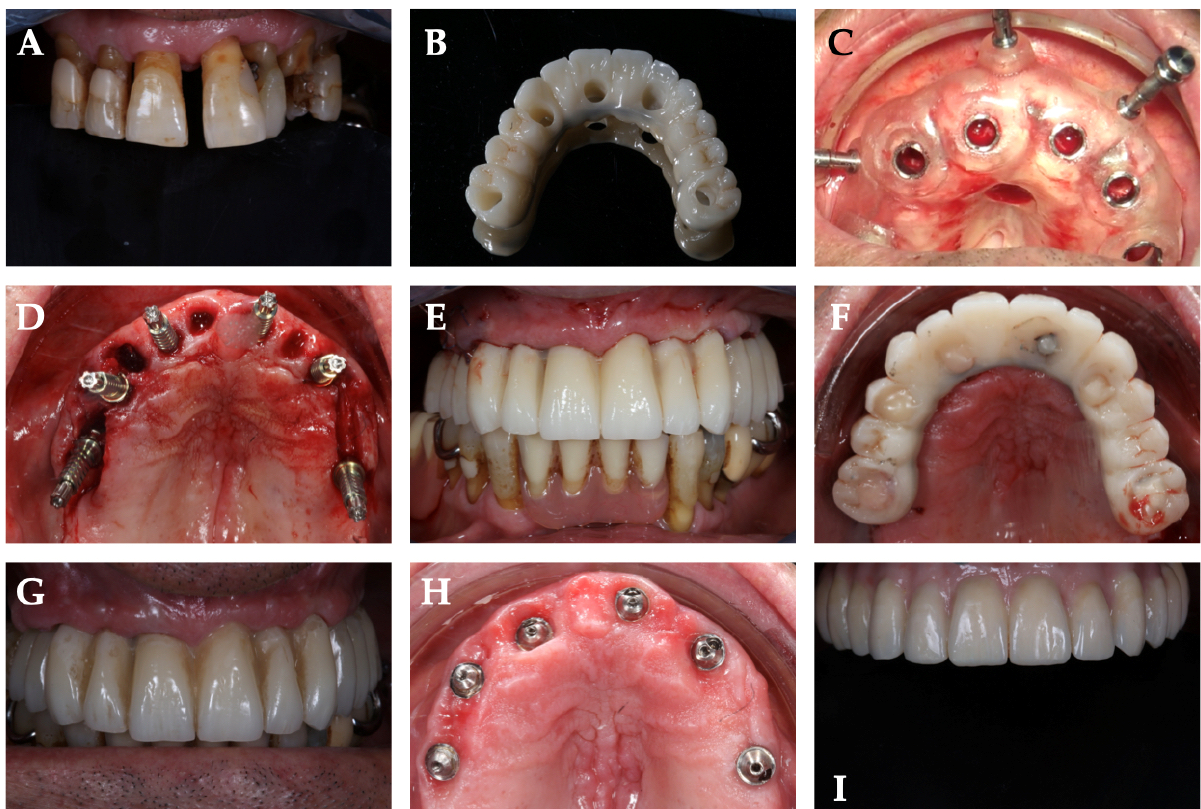
Figure 6. Demonstrative case from one of the treated patients: ( A ) preoperative image of hopeless dentition. Patient was rehabilitated with full arch supported by 6 implants; ( B ) CAD–CAM-milled temporary prosthesis in PMMA with metal palatal reinforcement. The provisional was perforated at the level of the prosthetic emergencies in order to be positioned and fixed after implant insertion; implants and abutments; ( E ) frontal image of immediate loading provisional prosthesis; ( F ) occlusal